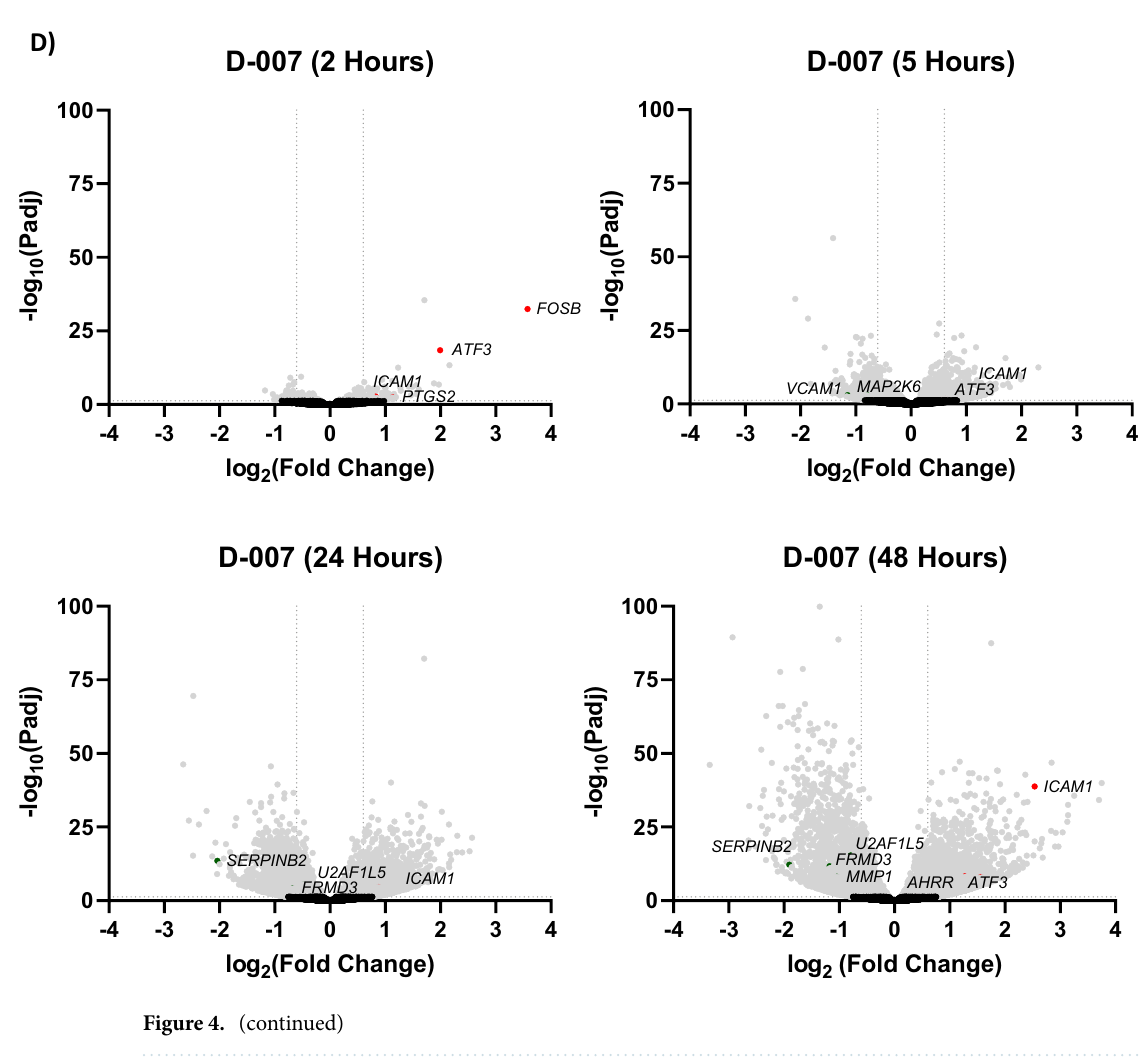
Figure 4. “On”- and “Off”-target Gene Regulation by PWO577 and SY007 in HUVECs. To identify gene regulation by EPAC1 activators, confluent HUVECs were stimulated for 16 h with PWO577 and SY007. Total RNA was then extracted and processed for RNAseq and plotted as a Venn diagram ( A ) or volcano plots ( B , C ), as described in “Materials and methods”. In the upper panel of ( B , C ) the data represents gene expression regulated by both PWO577 and SY007, encompassing 11,139 shared gene expression changes, whereas the lower panel demonstrates genes regulated solely by either PWO577 ( B ) or SY007 ( C ), representing either 250 or 219 gene expression changes, respectively. Significant gene expression changes (p > 0.05) are shown in light grey with changes in gene expression greater than 2-fold indicated either red (increase in gene expression) or green (decrease in gene expression). Non-significant gene changes are presented in black. In ( D ), previously published data 29 has been re-analysed to demonstrate changes in gene expression promoted by a time-course of D-007 treatment. Named genes represent those that were also regulated by either PWO577 or